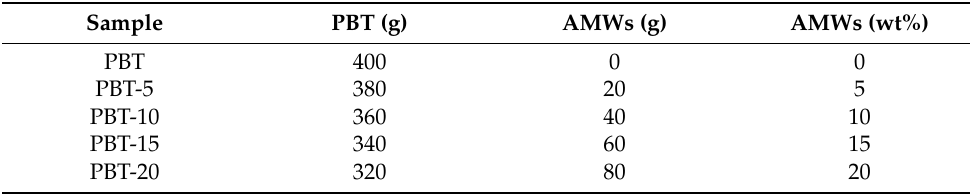
Table 1. The formulations of PBT and PBT/AMWs